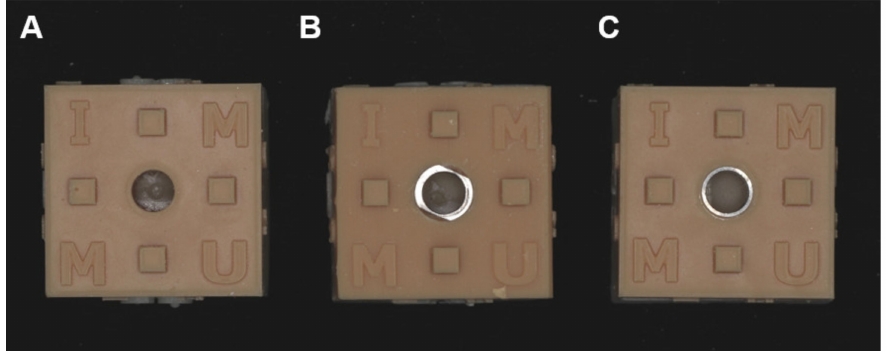
Figure 4. The final preparation of surgical guides with bone models. ( A ). Non-sleeve w/o key handle, ( B ). Metal sleeve w/o key handle, ( C ). Metal sleeve w/ key handle.